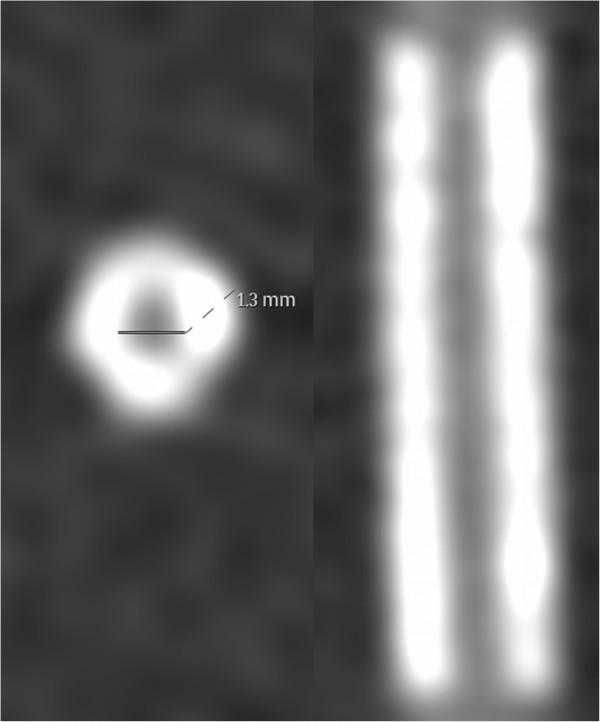
Example of the halo effect. The ALN for this stent was manually measured as 45%. However, the lumen visualization was considerably impaired by the halo effect (Medtronic Endeavor Resolute, nominal diameter 2.25 mm, length 12 mm).